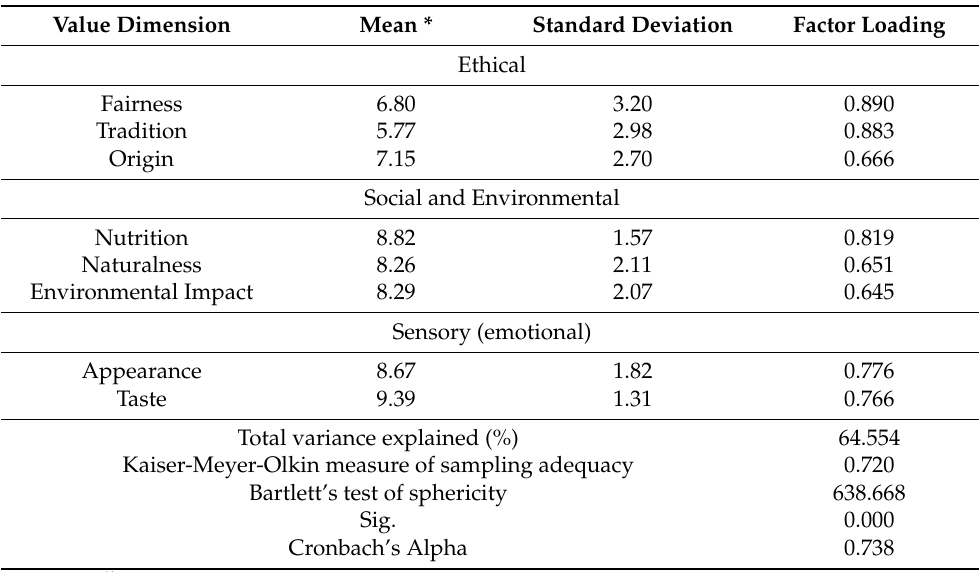
Table 3. Summary of factor analysis results for food values of